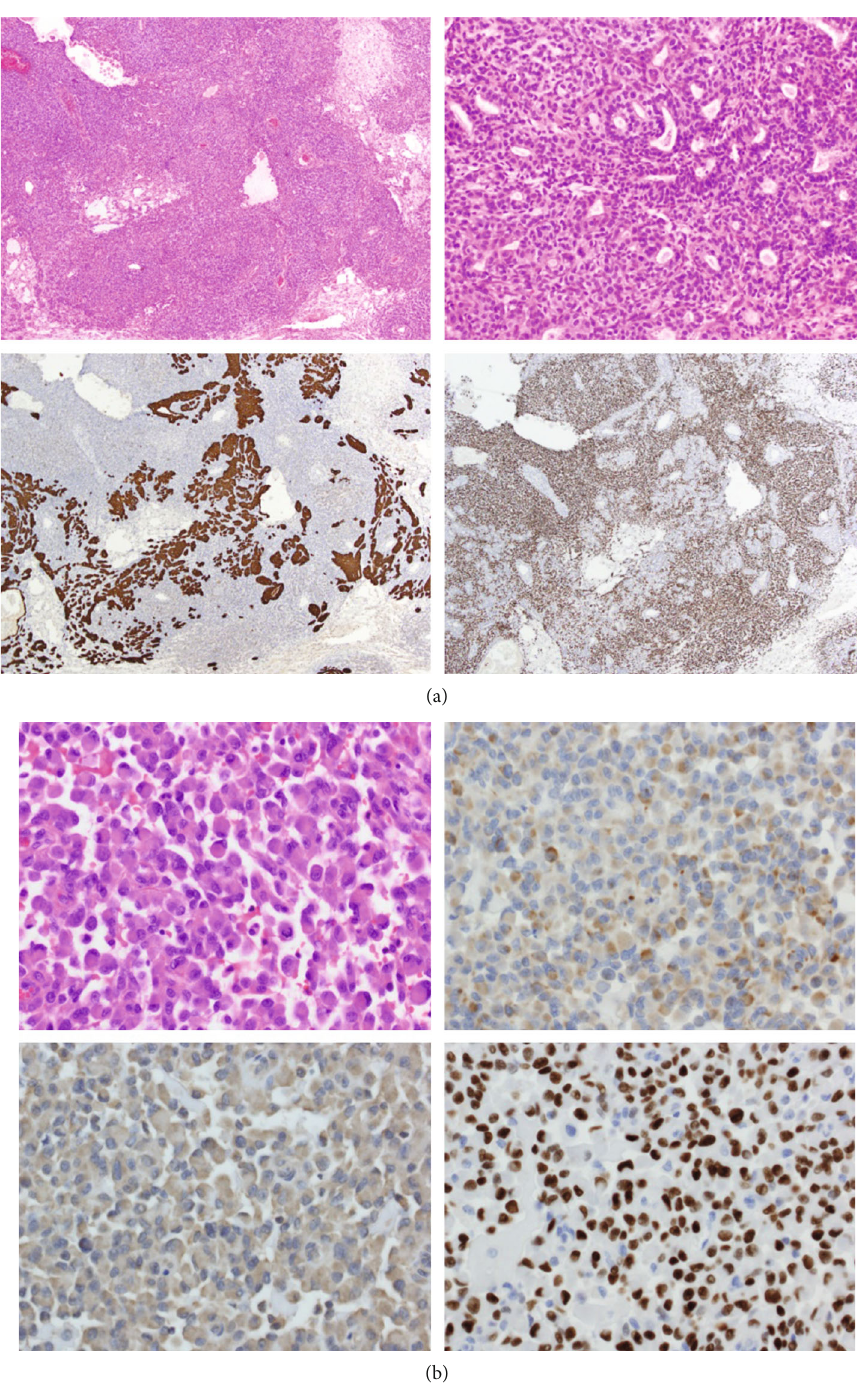
Figure 2: Histopathology of epithelial-myoepithelial carcinoma with rhabdoid features. (a) Top left : low-power (40x) representative area with a mixed glandular epithelial-myoepithelial architecture. Top right : high-power (200x) representative area with a mixed glandular epithelial-myoepithelial architecture. Bottom left : low-power (40x) CK8/18 IHC of the same area. Bottom right : low-power (40x) p63 IHC of the same area. (b) Top left : high-power (400x) representative rhabdoid area. Top right : high-power (400x) myogenin IHC of the same rhabdoid area. Bottom left : high-power (400x) CK8/18 IHC of the same rhabdoid area. Bottom right : high-power (400x) p63 IHC of the same rhabdoid